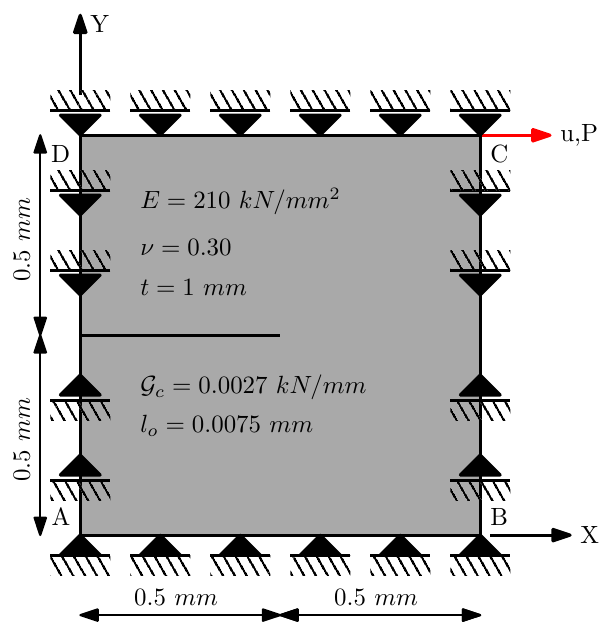
Figure 17. Shear test geometry, material parameters, loading and boundary